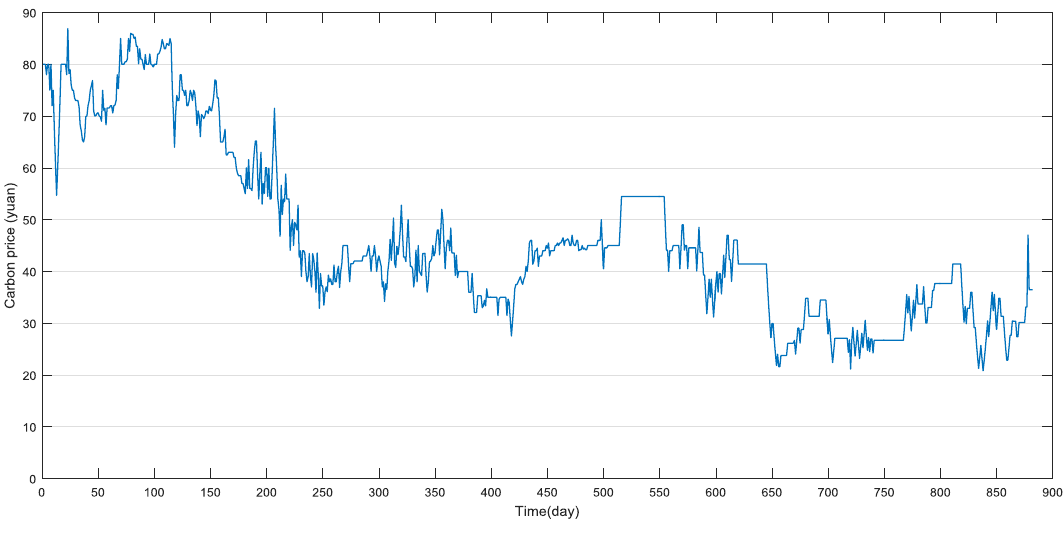
Figure 2. The carbon price fluctuations of SZA2013. Table 1. Statistical descriptions of the carbon price of SZA2013.